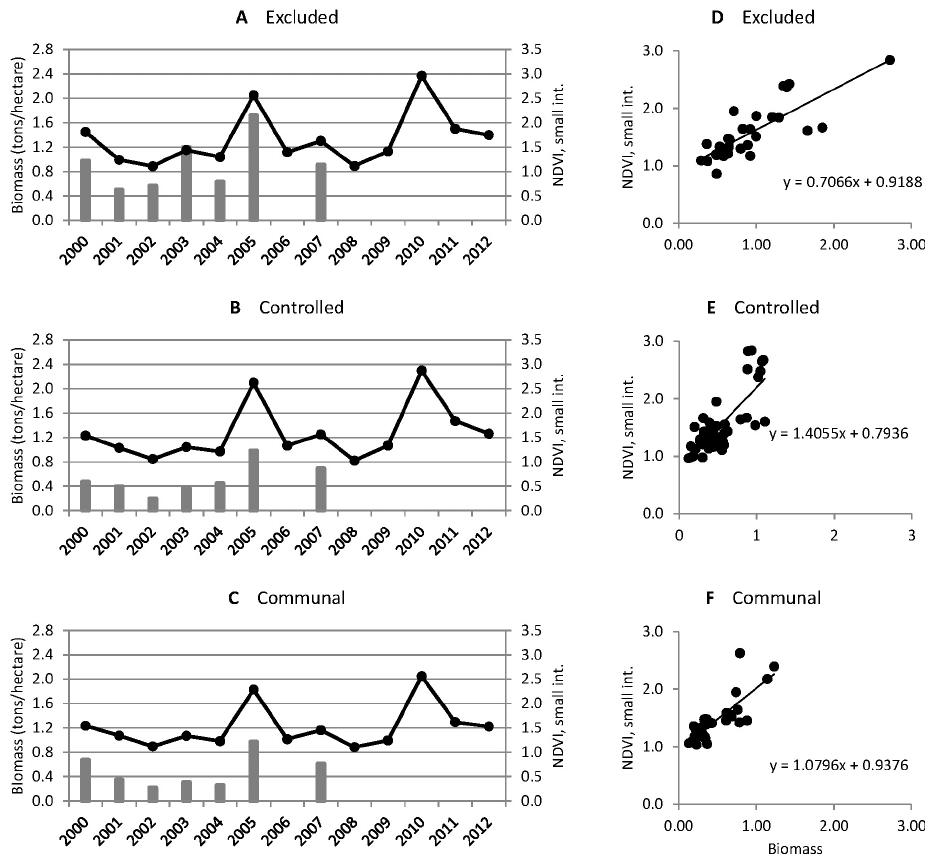
Figure 4. (a) , (b) and (c) : black lines showing annual values of MODIS NDVI small integrals for pixels covering vegetation sampling plots, averaged for each grazing regime. Grey bars showing ESSB averaged by grazing regime. (d) , (e) and (f) show relations between individual measurements of plot ESSB and MODIS NDVI small